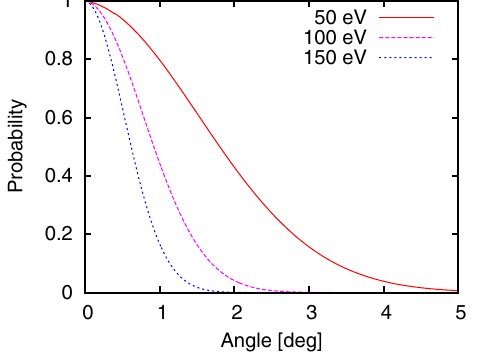
FIG. 1. Specular photon reflectivity as a function of the angle of incidence for several different photon energies, considering a 10 nm carbon layer on top of a copper surface and 50 nm rms surface roughness.